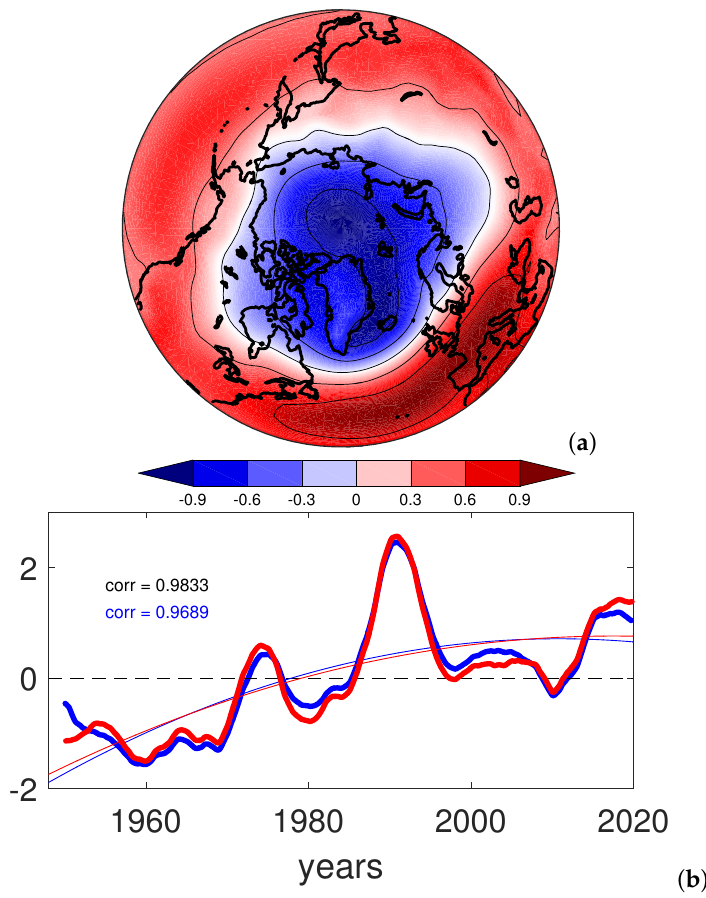
Figure 1. The first EOF mode of sea level pressure decomposition: ( a ) the spatial distribution of the eigenvector of the mode, ( b ) the time-series of the principal component (blue line) in comparison with the time-series of the Arctic oscillation index given by the Climate Prediction Center (https: //www.cpc.ncep.noaa.gov) (red line). Both curves were obtained as a result of a 5-year moving averaging with further normalization. The correlation of these series is 0.9852. After subtracting quadratic trends (thin lines of the corresponding colors), the correlation is